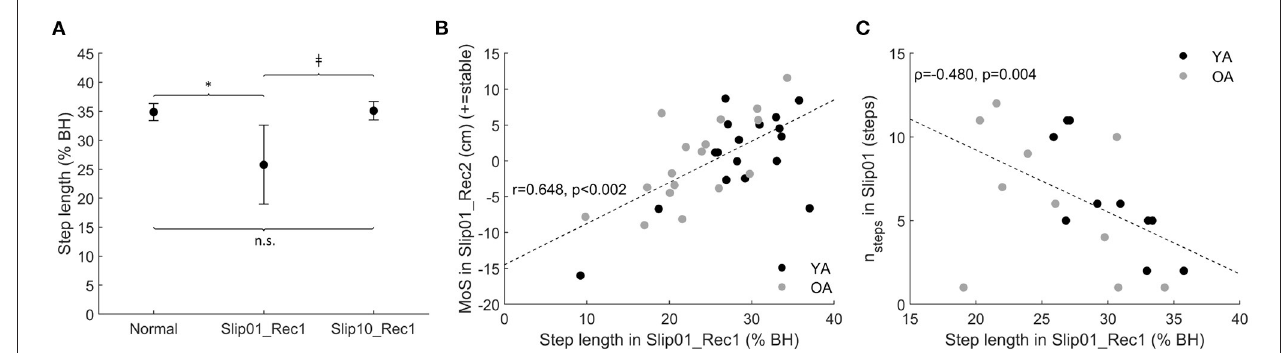
FIGURE 10 | (A) Step length of Slip01_Rec1 and Slip10_Rec1 compared with Normal (average ± SD as error bars); *: significantly shorter than Normal, p < 0.001; ‡: Slip10 significantly longer than Slip01, p < 0.001; n.s.: no significant difference between conditions. See Supplementary Figure 8 for participants’ data points. (B) Correlation between step length in Slip01_Rec1 and MoS of Slip01_Rec2 ( r = 0.648, p < 0.001). Black circles: young adults; grey circles: older adults. (C) Correlation between step length in Slip01_Rec1 and n steps (first of at least three consecutive steps within one standard deviation of normal MoS) in Slip01 (Spearman’s rho = − 0.480, p = 0.004), participants whose n steps had not returned to Normal by Rec15 were removed from the correlation analysis. Black circles: young adults; grey circles: older adults. % BH: % of body height.